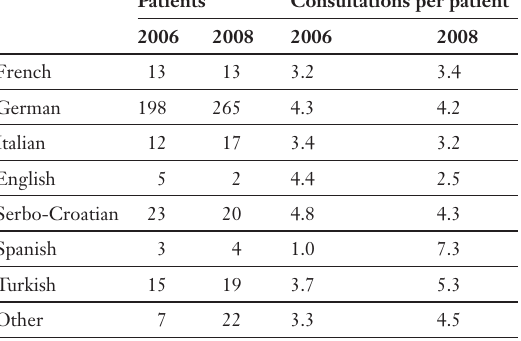
Table 1 Number of patients and number of consultations per mother